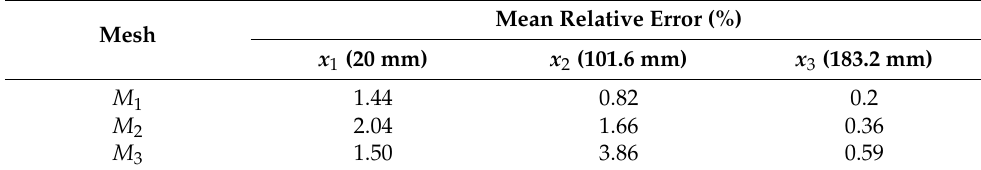
Mean Relative Error